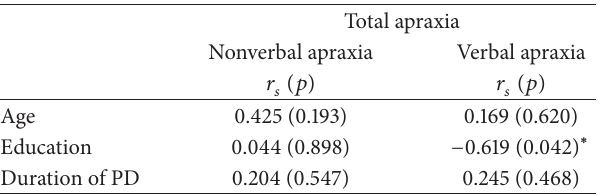
Table 5: Correlation between nonverbal apraxia and verbal apraxia with age, education, and duration of